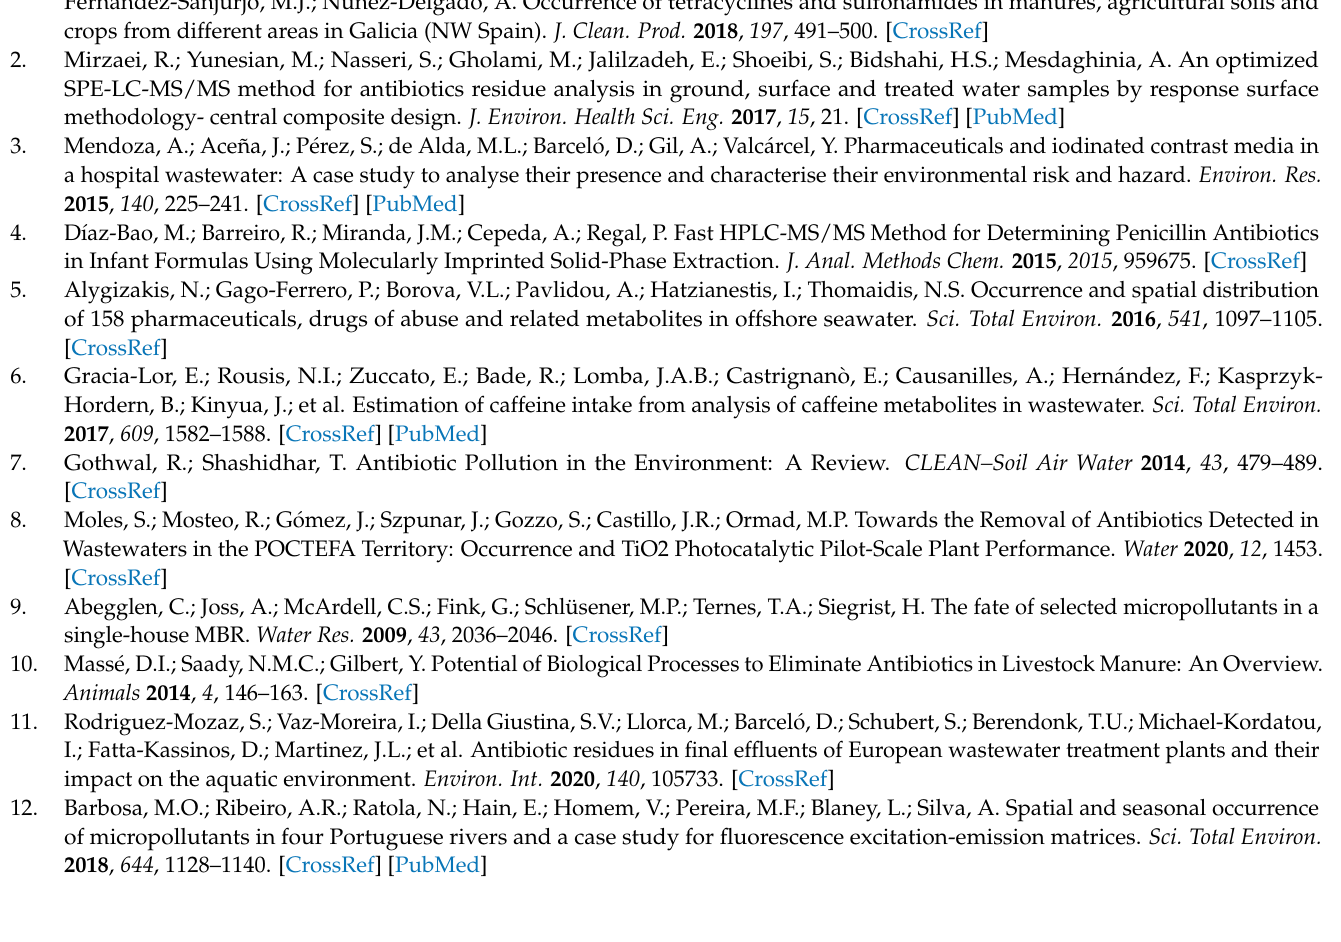
Table S8. One-way ANOVA test of antibiotics concentration in WWTPs. Table S9. Tukey’s honestly significant difference test results in